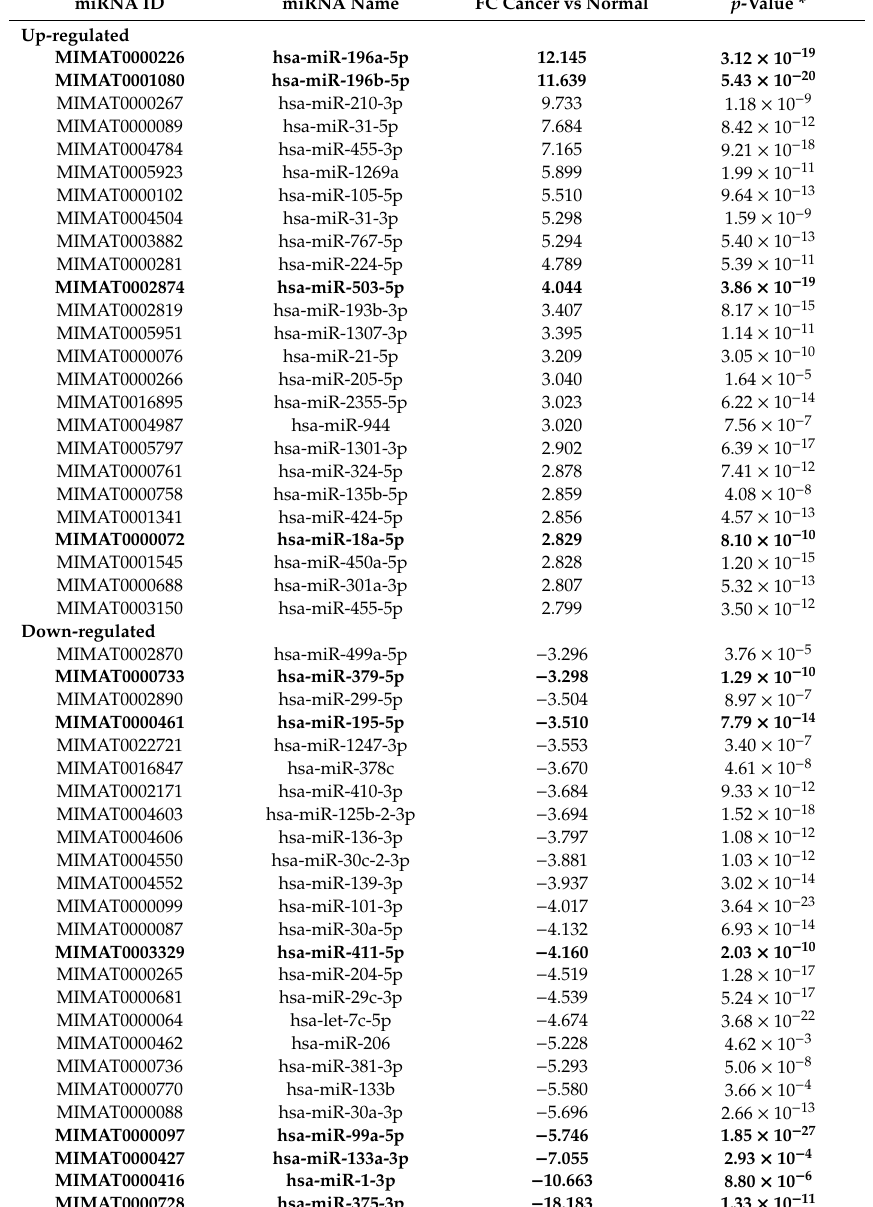
Table 2. TCGA analysis of up-regulated and down-regulated miRNAs in the tumor compared to the normal